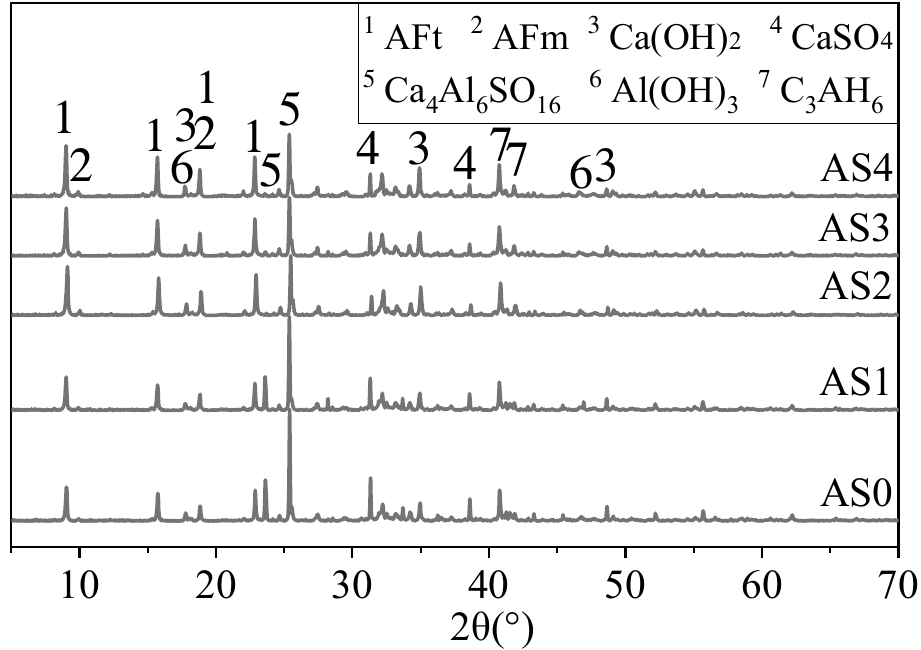
Figure 9. XRD patterns of the double liquid grouting materials with different aluminum sulfate contents at 1 day.